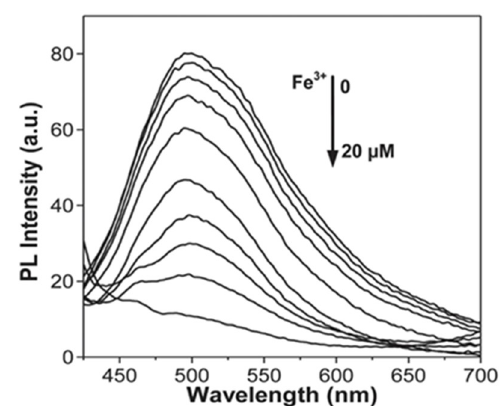
Figure 4. PL intensity changes due to the Fe 3+ application on the quenching mechanism ( λ ex = 400 nm). Fe 3+ ions are indispensable, and it was hypothesized that GQDs can be a detector of Fe 3+ since they have phenolic hydroxyl groups. These results indicate that luminescent GQDs can also be used to detect Fe 3+ [70].